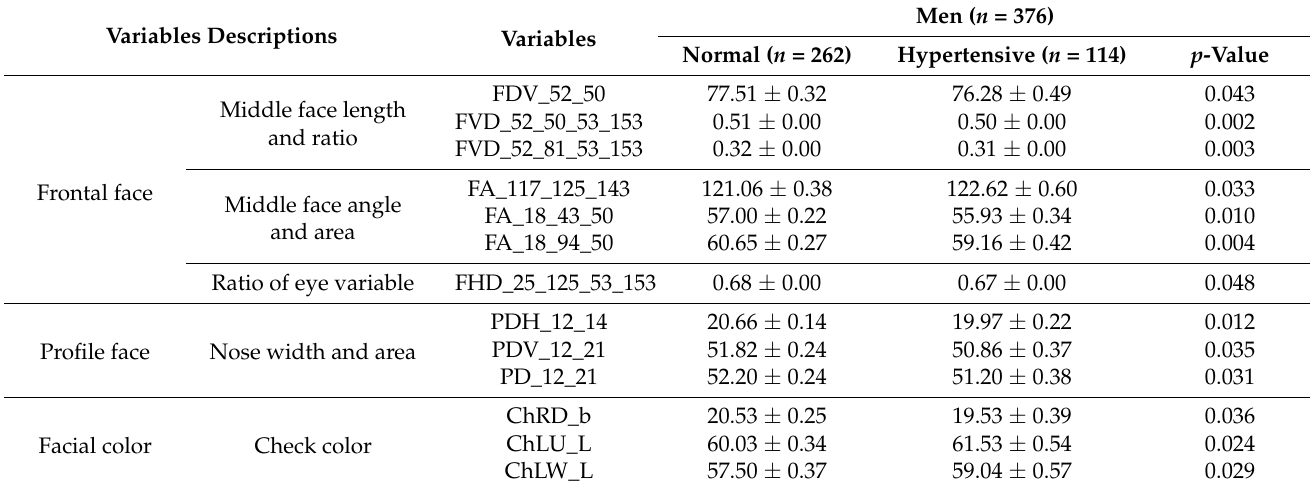
Table 4. Differences in facial characteristic variables in